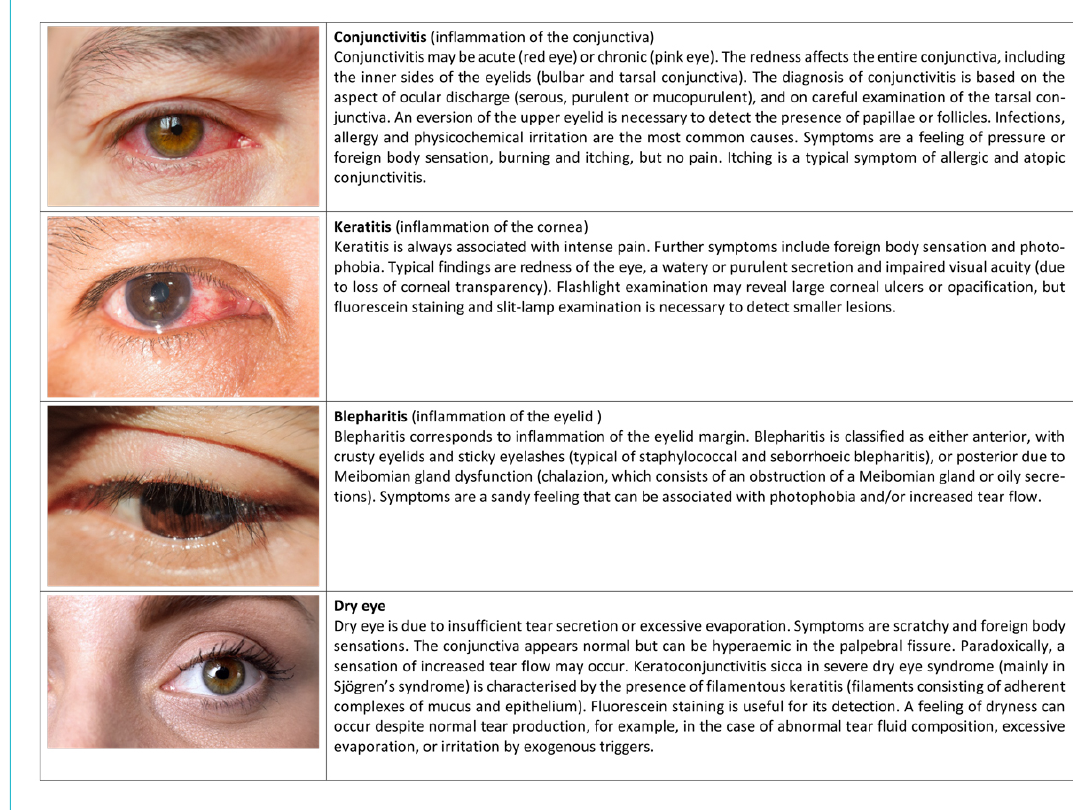
Figure 1: Common ocular surface diseases in atopic dermatitis patients. Stock pictures by istock and